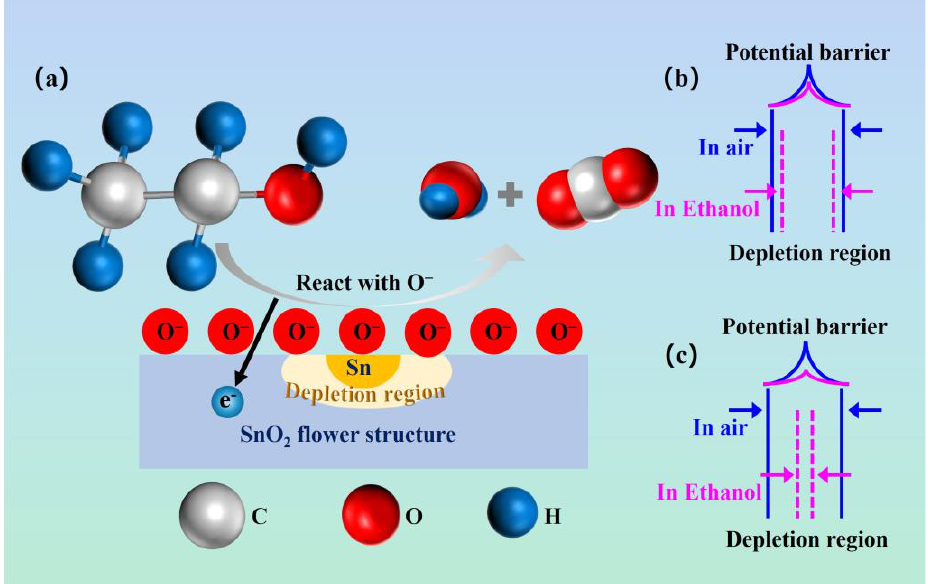
Figure 10. Sensing response at different RH levels for ethanol concentrations of 1000 ppm at 250 ℃ .